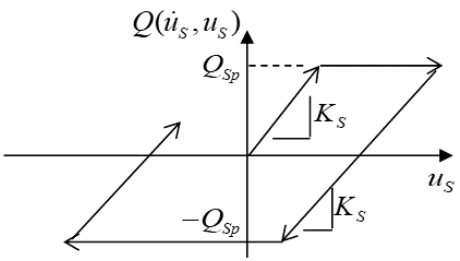
Figure 2. Idealized elastoplastic model of steel slab in a hybrid system.